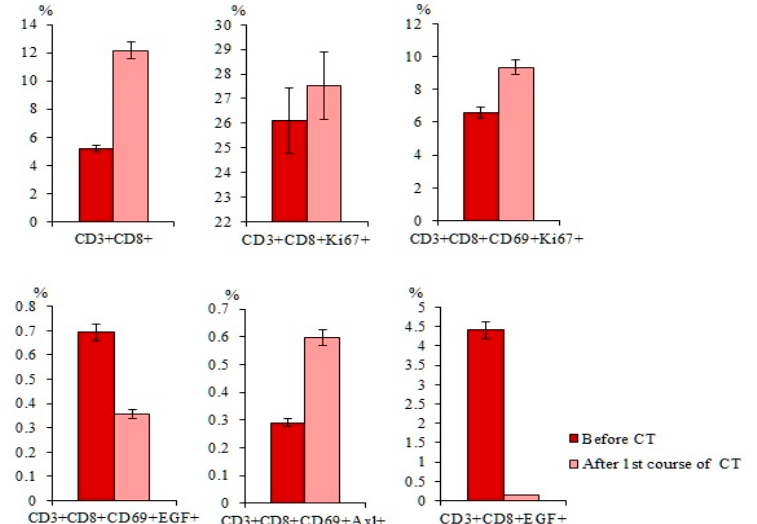
Figure 8. The content of CD3 + С D8 + , CD3 + С D8 + Ki67 + , CD3 + С D8 + CD69 + , CD3 + С D8 + CD69 + Ki67 + , CD3 + С D8 + CD69 + EGF + , CD3 + С D8 + CD69 + Axl + , and CD3 + С D8 + EGF + T-lymphocytes in the blood of SCLC patients before and after first course of chemotherapy (CT) (% of all labelled mononuclear cells). Cells were analyzed by flow cytometry using antibodies against CD3, CD8, CD69, EGF, Axl, and Ki67.